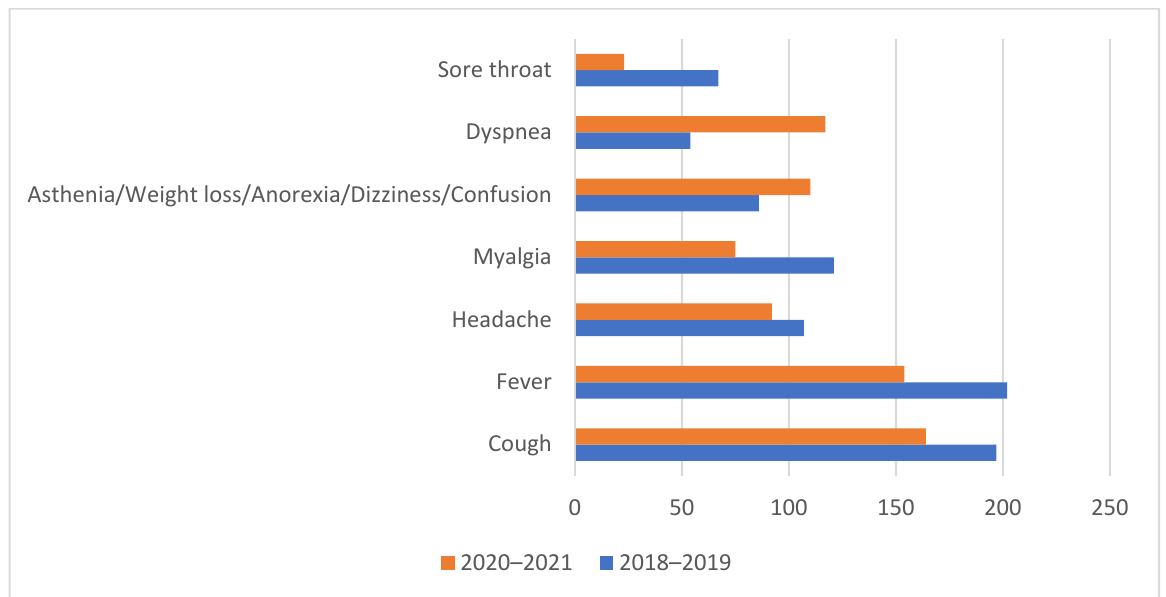
Figure 2. The distribution of symptoms presented at admission between the two studied groups. 172 Immunodepression, including HIV (16.1% vs. 6.9%, p < 0.05) and pulmonary condi- 173 tions (26.7% vs. 7.6%, p < 0.01), were found more frequently in influenza patients while 174 obesity (53.8% vs. 26.7%, p < 0.01) was found more frequently in COVID-19 patients (Table 175 1).